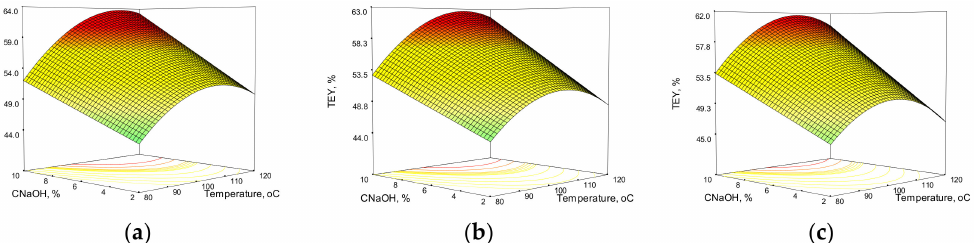
Figure 4. Response surfaces and contour plots of the combined effects of sodium hydroxide concen- tration and temperature on total extraction yield from corn stalks at various reaction times: ( a ) 60 min; ( b ) 90 min; ( c ) 120 min.